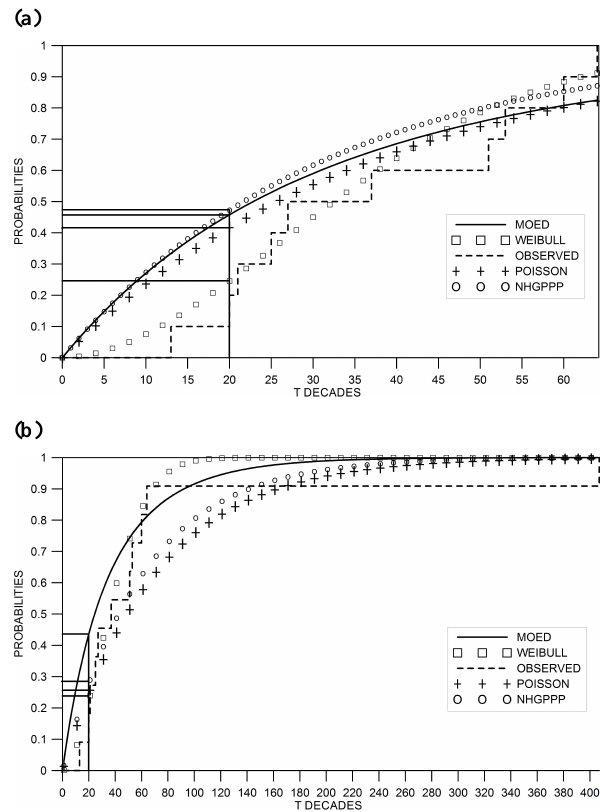
Fig. 3. Probabilities calculated by NHGPPP, MOED, Poisson and Weibull distributions of at least one eruption, with VEI ≥ 3 in a given time interval from (a) “El Chich´on 2” over 3707years BLE. The horizontal and vertical lines show the different probabilities of at least one eruption in 20decades with VEI ≥ 3 (NHGPPP: 0.4724, MOED: 0.4582, the Weibull distribution: 0.2460 and Poisson dis- tribution: 0.4170), and (b) “Chich´on B” over 7772years BLE erup- tive models. This is equivalent to the probability of observing a repose time less or equal than T decades. The horizontal and ver- tical lines show the different probabilities of at least one eruption in 20decades with VEI ≥ 3 (NHGPPP: 0.2777, MOED: 0.4371, the Weibull distribution: 0.2219 and Poisson distribution: